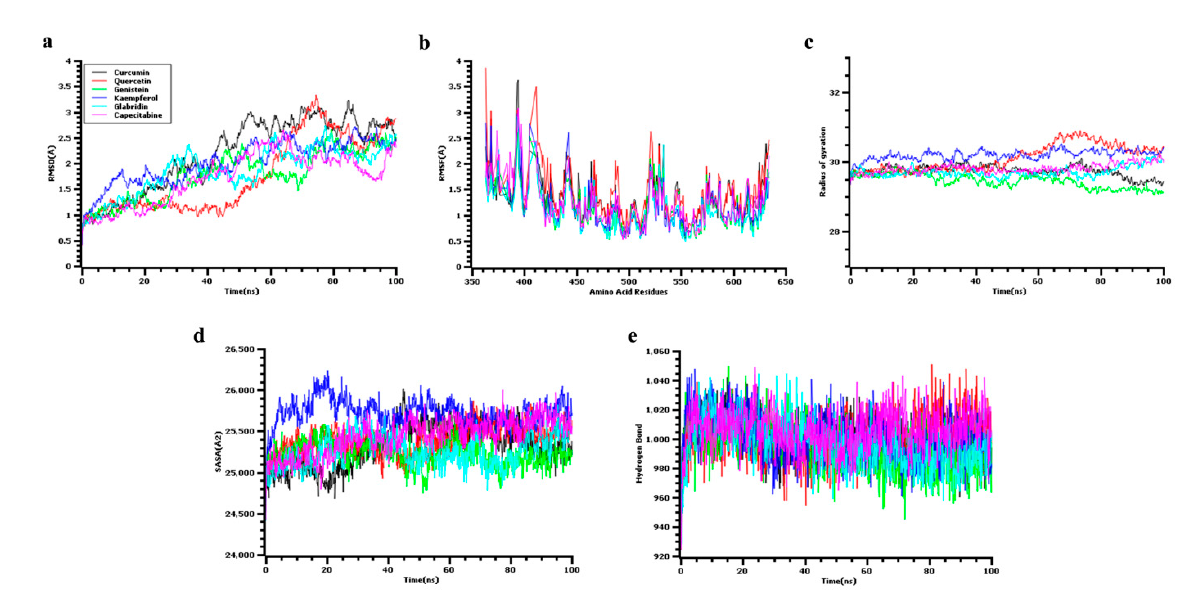
Figure 8. ( a ) The RMSD values were obtained individually by a molecular dynamic simulation of each ligand with the SYK targeted receptor. ( b ) RMSF values were obtained from a molecular dynamic simulation of each ligand when simulated precisely and independently with the target receptor. ( c ) Rg throughout the simulation. ( d ) SASA. ( e ) Maximum number of H-bonds during the simulation.